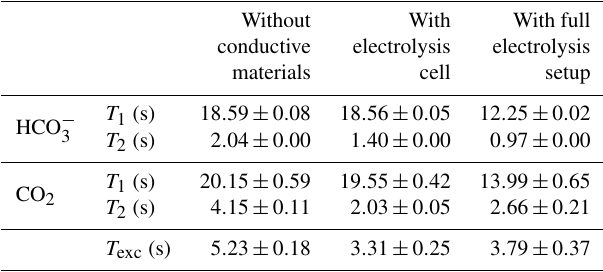
Table 3. Relaxation and exchange times for bicarbonate and car- bon dioxide without conductive materials, with the disconnected electrolysis cell and with full electrolysis setup at 10 ◦ C. The full electrolysis setup included the in operando cell, connection cables, a powered potentiostat and shielding equipment. For measurements using the electrolysis setup, no electrochemical experiments were conducted.